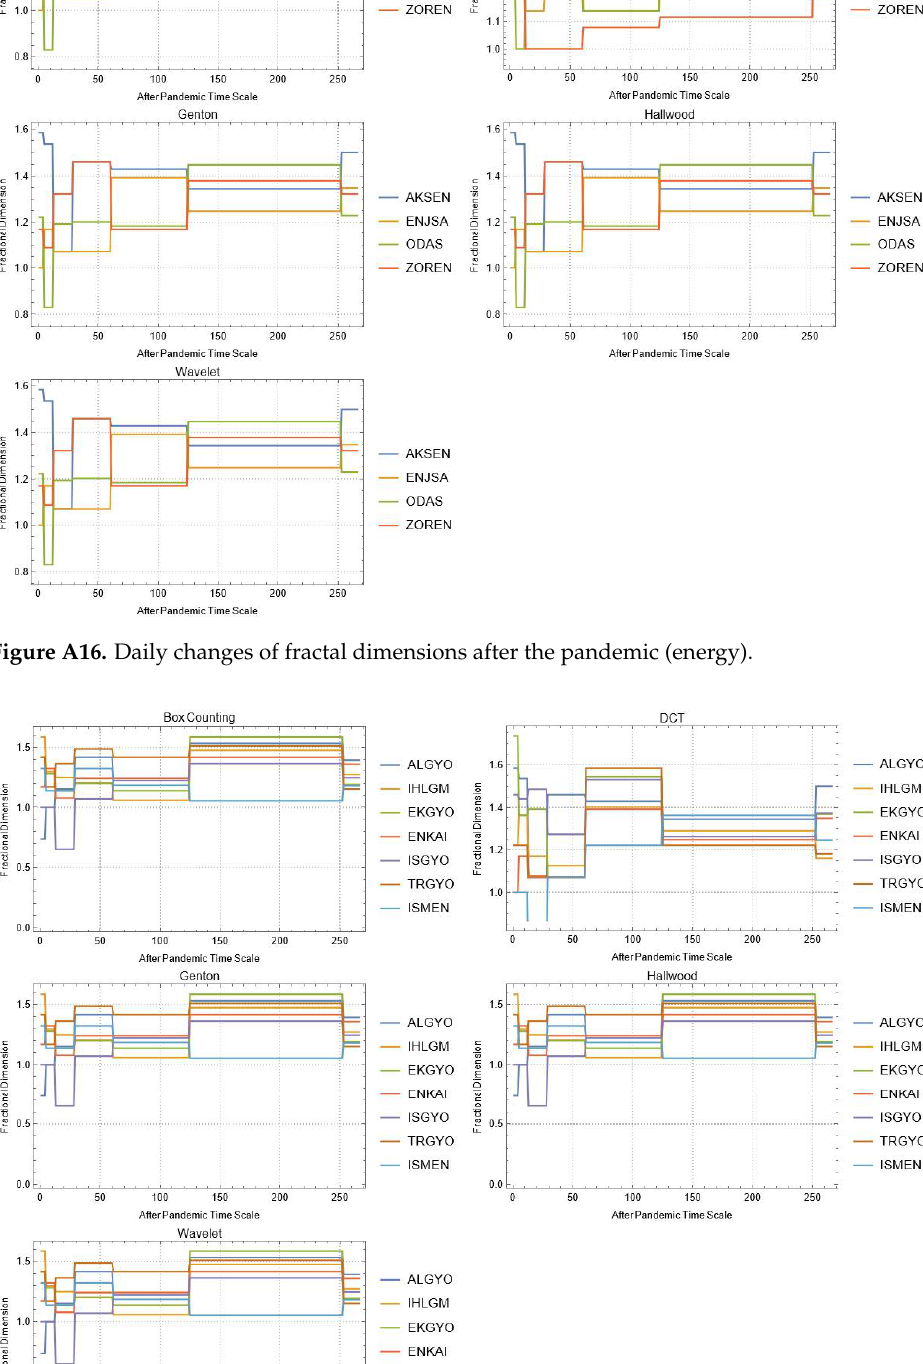
Figure A17. Daily changes of fractal dimensions after the pandemic (real estate).